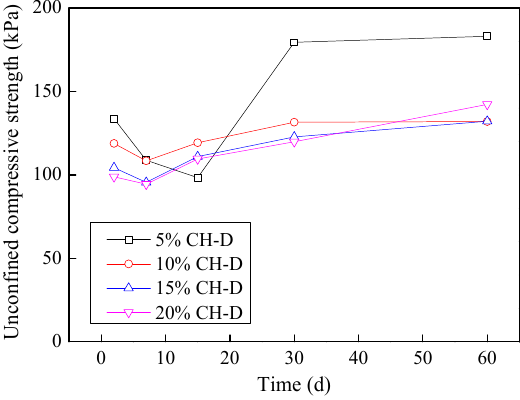
Figure 15. Effects of dyeing effluent on the cohesion of CH soil samples.